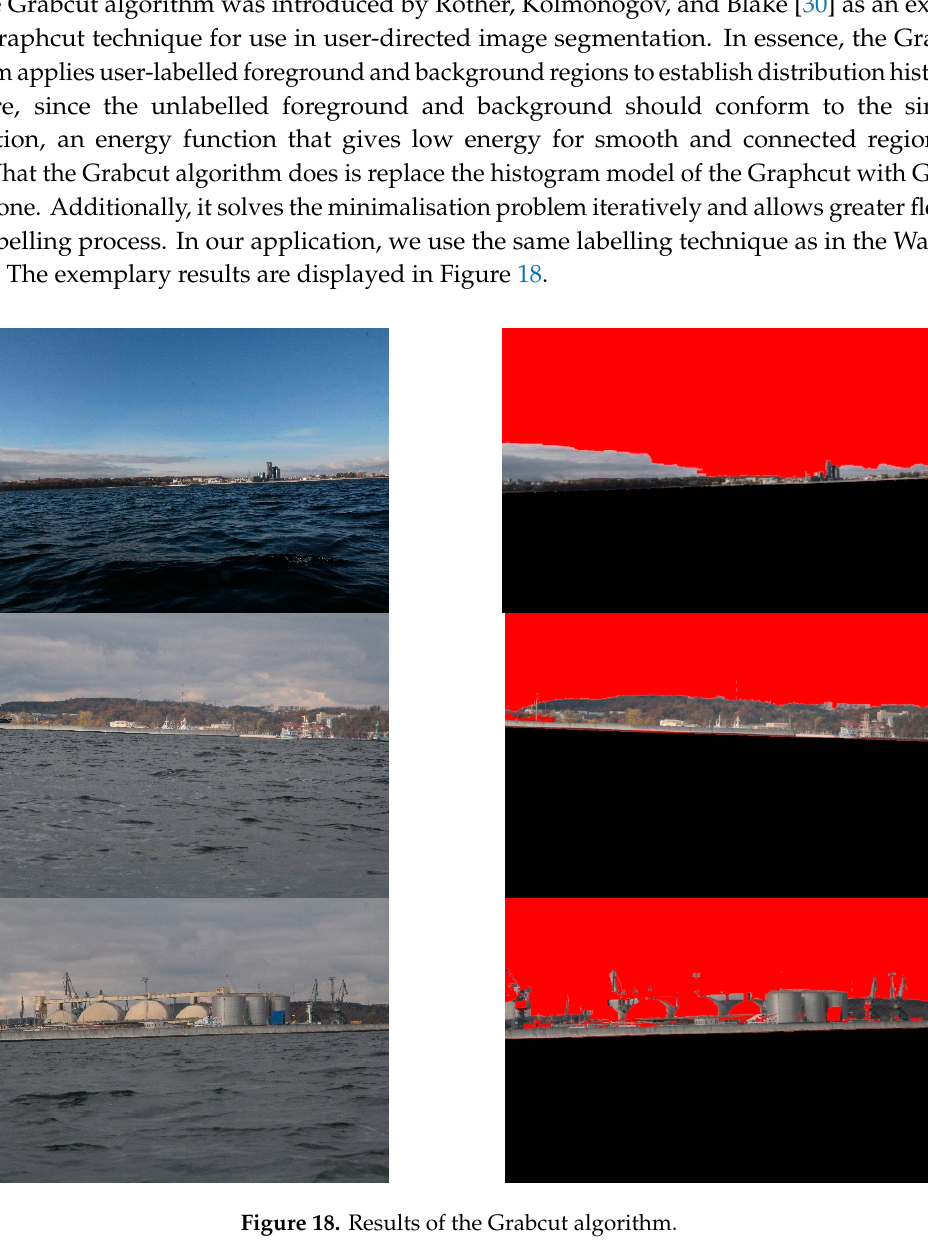
Table 6. Results of land segmentation using the Grabcut algorithm.